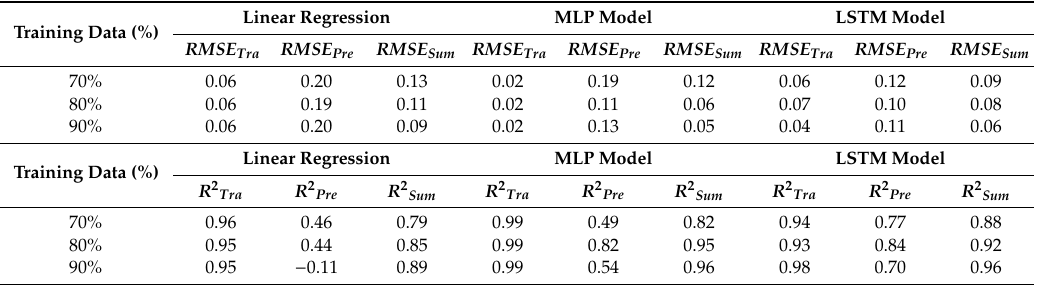
Table 2. The trained and predicted groundwater recharge results based on the three models and the percentage of observation data used to train the